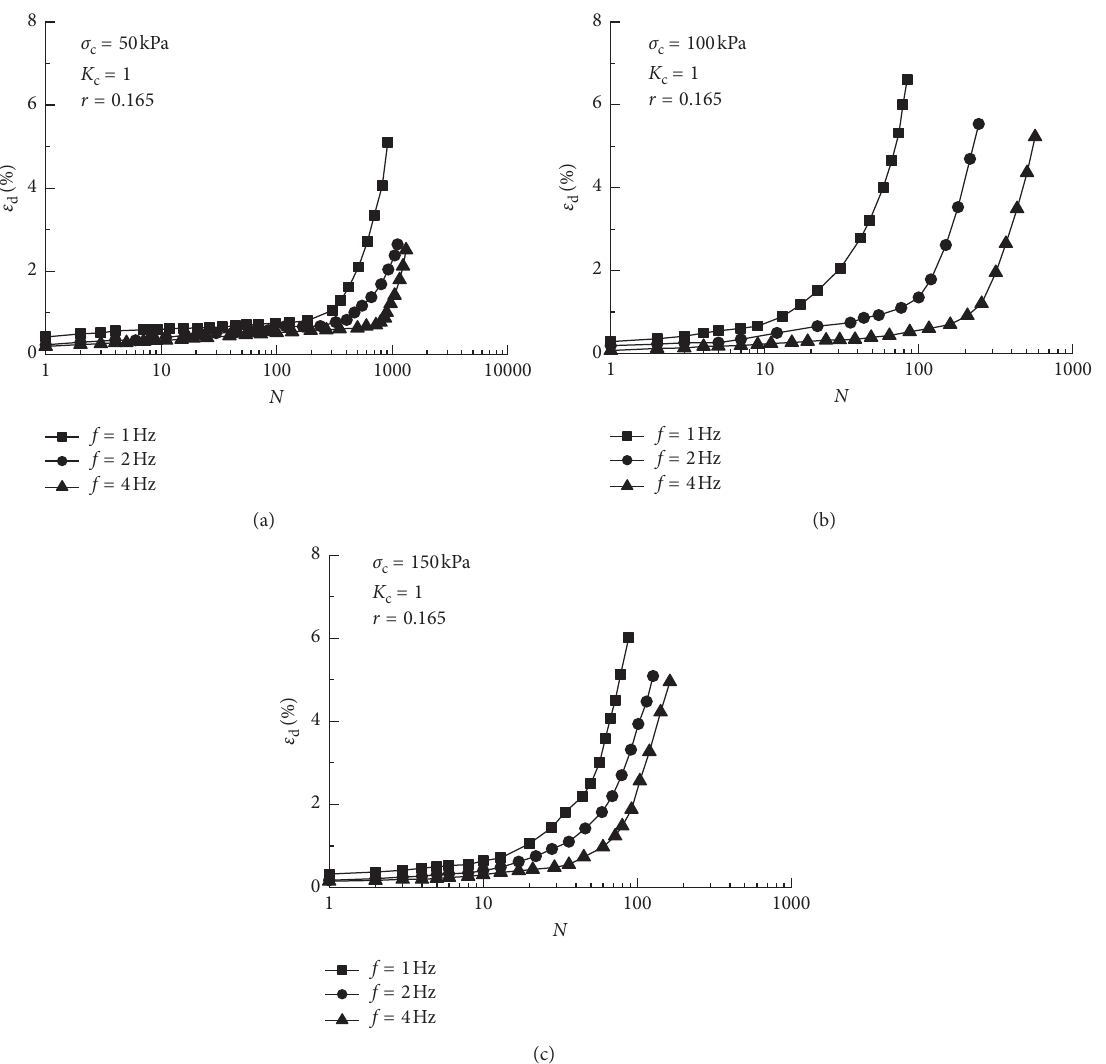
Figure 9: Relationship curves between ε